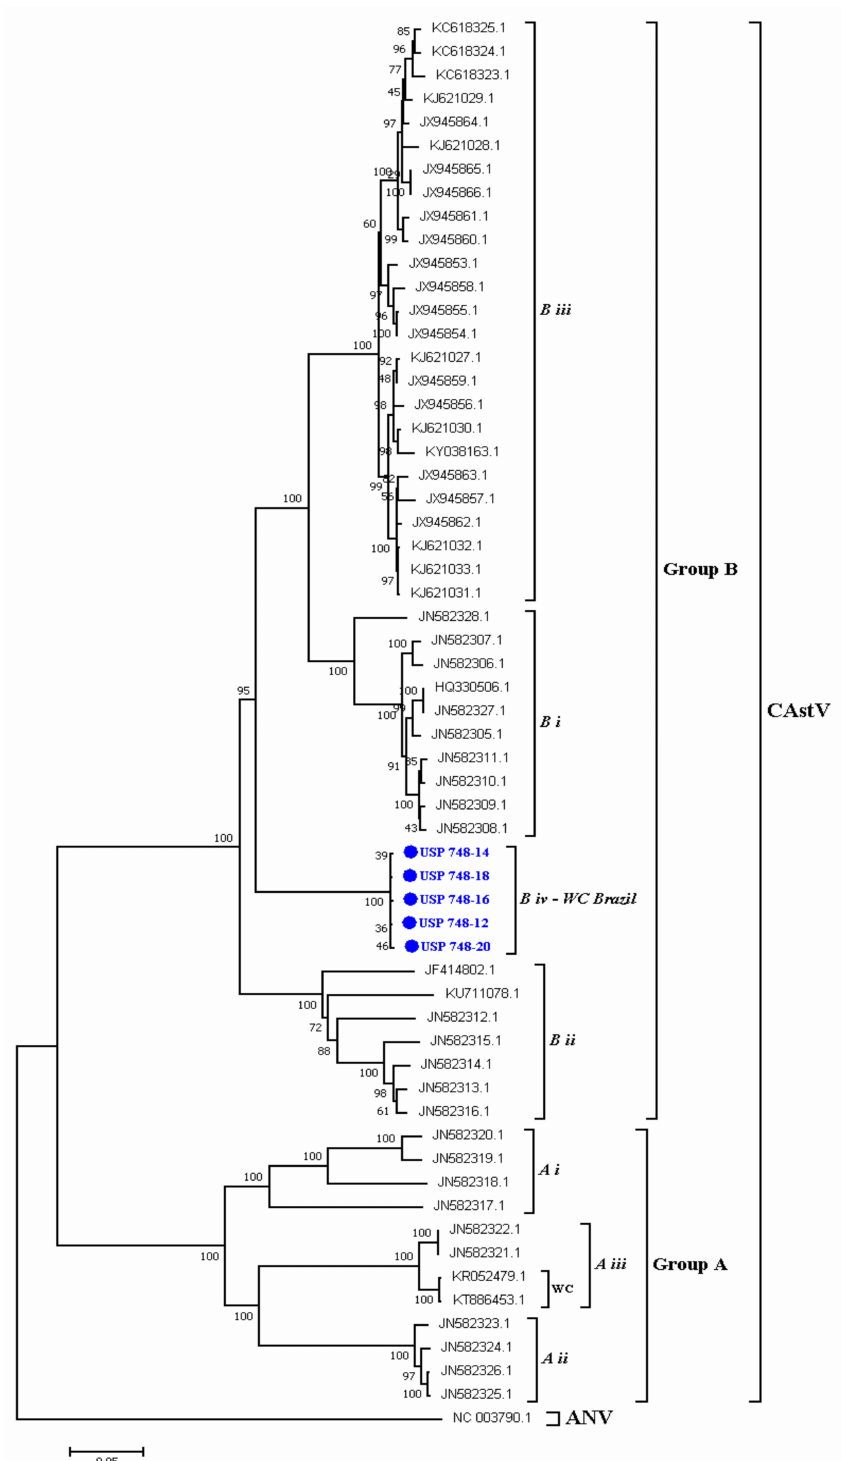
Figure 4. Phylogenetic relations between the sequences of CAstV belonging to chicks naturally infected with WCS obtained in the present work and other sequences of CAstV based on complete ORF2 gene nucleotide sequences. Sequences were aligned using the CLUSTAL W method in ClustaX2 2.1. The phylogenetic tree was constructed using the MEGA 7 Software Package. The numbers along the branches refer to the bootstrap values of 1000 replicates. The scale bar represents the number of substitutions per site. Avian Nephritis virus (ANV) was used as the outgroup. The sequences obtained here are shown in